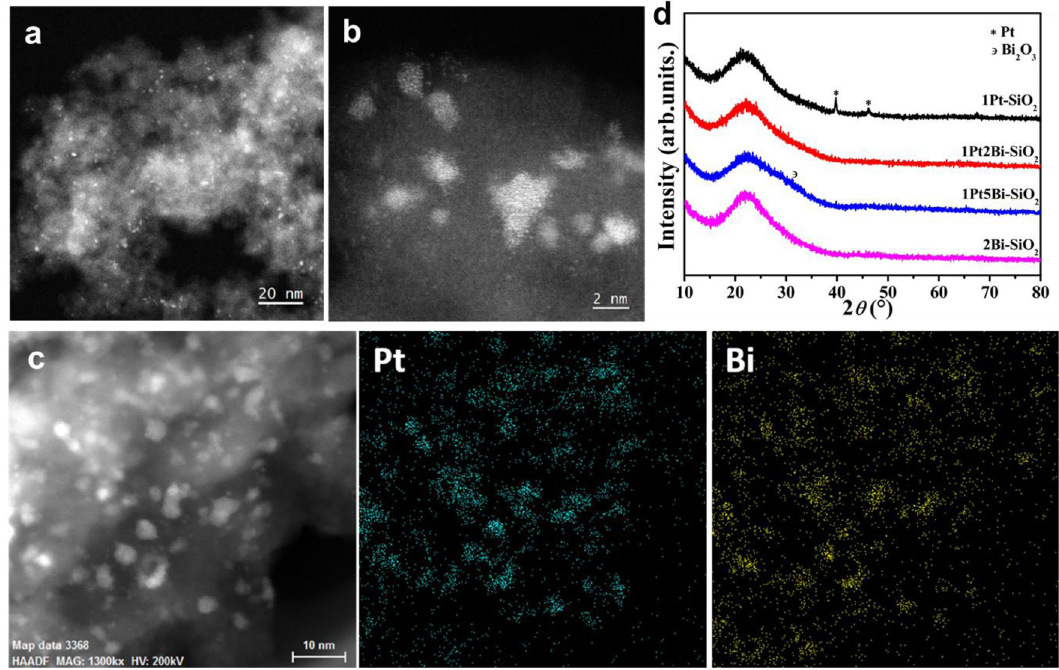
Fig. 1 Structural characterization of Pt/PtBi – SiO 2 samples. Representative aberration-corrected HAADF-STEM images ( a , b ) at different scales and corresponding STEM-EDS elemental mapping images c for fresh 1Pt2Bi-SiO 2 ; XRD patterns ( d ) of fresh Pt/PtBi-SiO 2 samples.